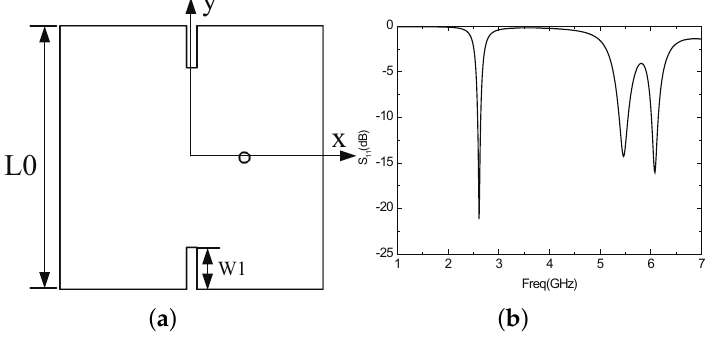
Figure 16. ( a ) Antenna structure with a rectangular slot; ( b ) The parameter S 11 of the antenna with a rectangular slot.